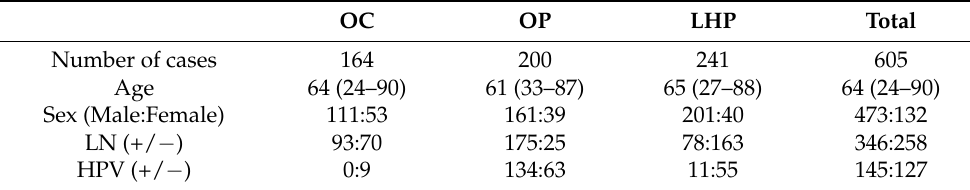
Table 1. Patient demographics and class distribution of lymph node metastasis (LN) and human papilloma virus (HPV) status across tumor sites—oral cavity (OC), oropharynx (OP), and larynx or hypopharynx (LHP). Note that for LN and HPV status, there are missing values for some